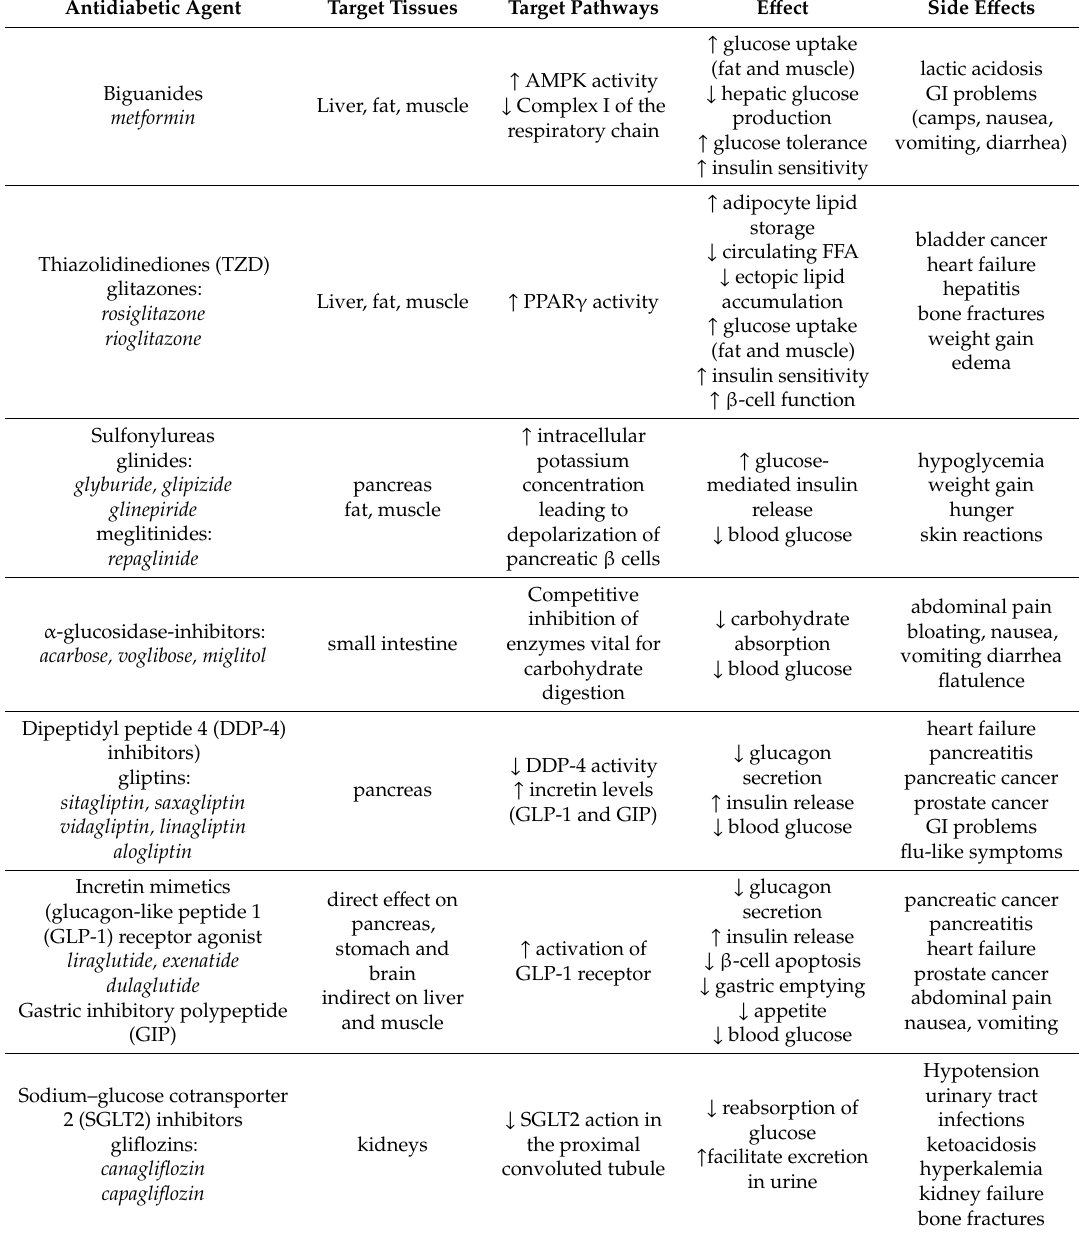
Table 2. Current pharmacological treatments for